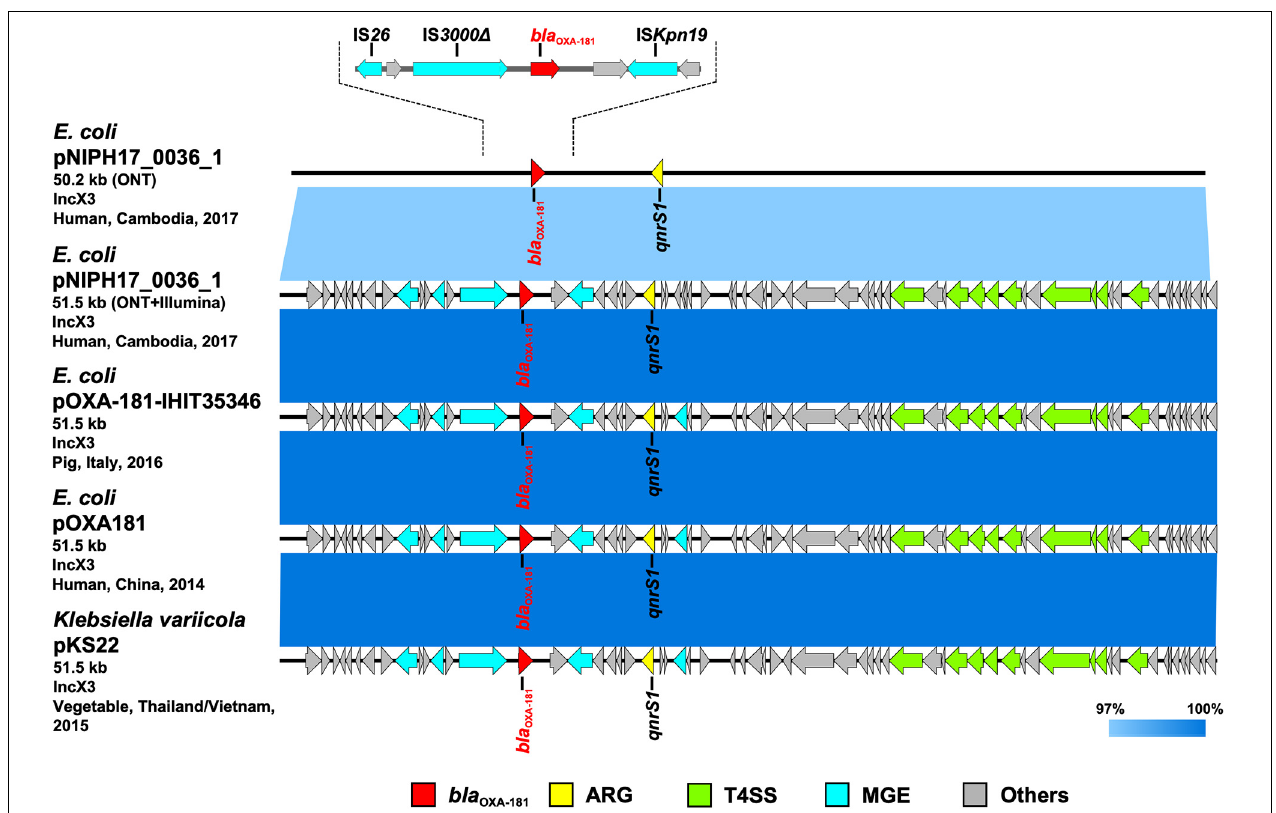
FIGURE 4 | Linear comparison of related plasmid sequences from Cambodia and other countries. E. coli pNIPH17_0036_1 with bla OXA − 181 (this study, accession no. LC483179), E. coli pOXA-181-IHIT35346 with bla OXA − 181 (accession no. KX894452), E. coli pOXA-181 with bla OXA − 181 (accession no. KP400525), and Klebsiella variicola pKS22 with bla OXA − 181 (accession no. KT005457) are shown. Regarding E. coli pNIPH17_0036_1, both the uncorrected sequence (from on-site ONT analysis) and corrected sequence (from subsequent ONT + Illumina analysis), and the detailed genetic structures around bla OXA − 181 are shown (upper). Red, yellow, green, blue, and gray arrows indicate carbapenemase gene ( bla OXA − 181 ), other AMR genes (ARG), type IV secretion system-associated genes involved in conjugation (T4SS), mobile gene elements (MGE), and other genes (Others), respectively. The colors in comparison of plasmids show percent identity.